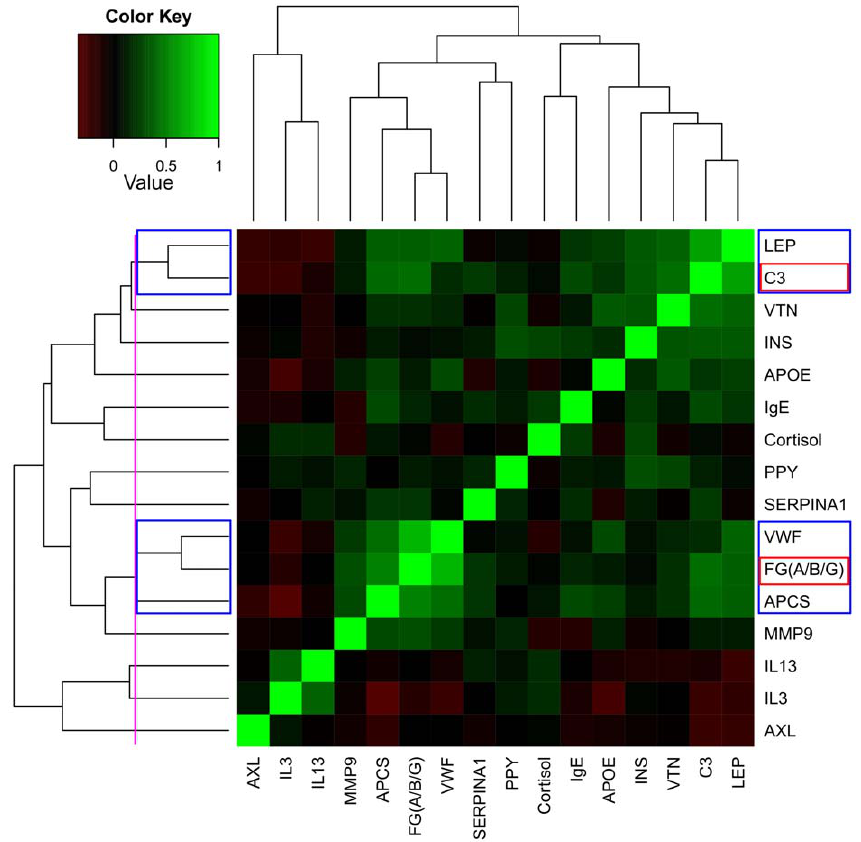
Figure 1. Analyte correlations. Heatmaps of partial SRC between RBM analytes significantly associated (p-value v 0.05) with brain amyloid burden, taking into account: age, gender, years of education, number of APOE E 4 alleles and the difference, in days, between plasma sampling and [ 11 C]-PiB PET scan date. RBM analytes have been ordered by hierarchical clustering, the final cut-off is shown in purple. Variables that have been grouped are shown in blue boxes, and the representative for each group is shown in a red